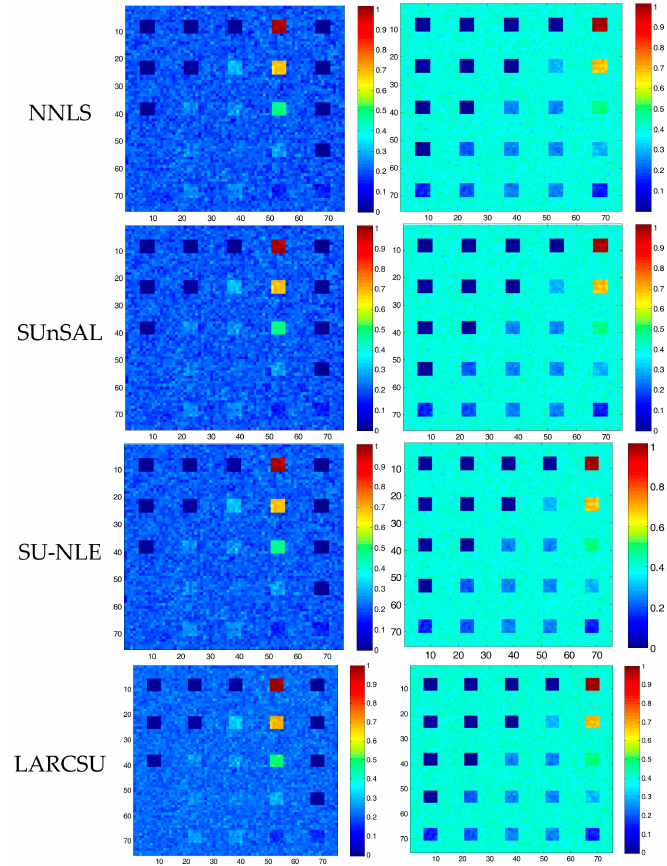
Figure 7. Estimated abundances of endmembers for